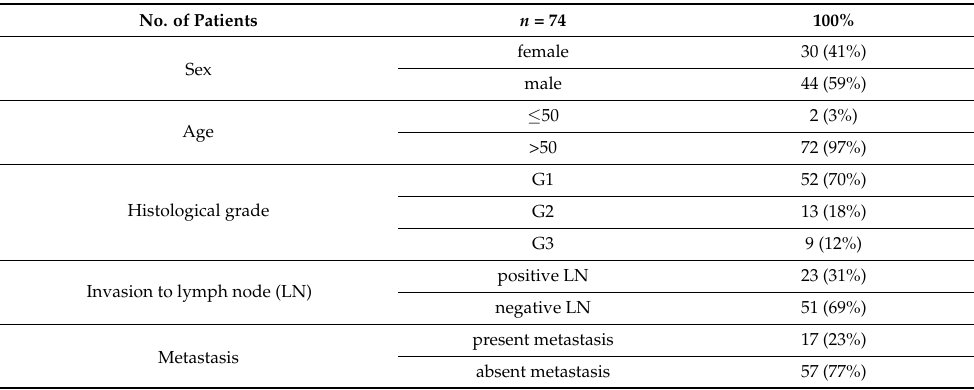
Table 1. The characteristics of patients and